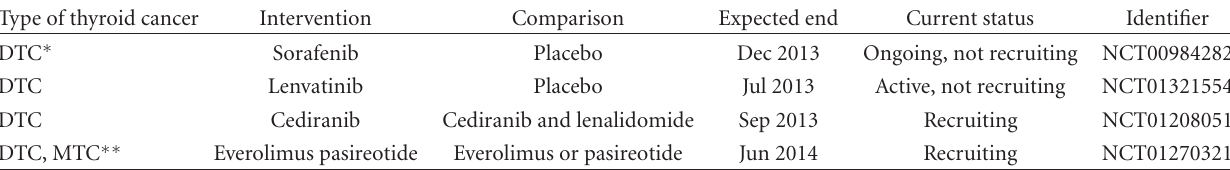
Table 3: Ongoing comparative drugs trials in thyroid